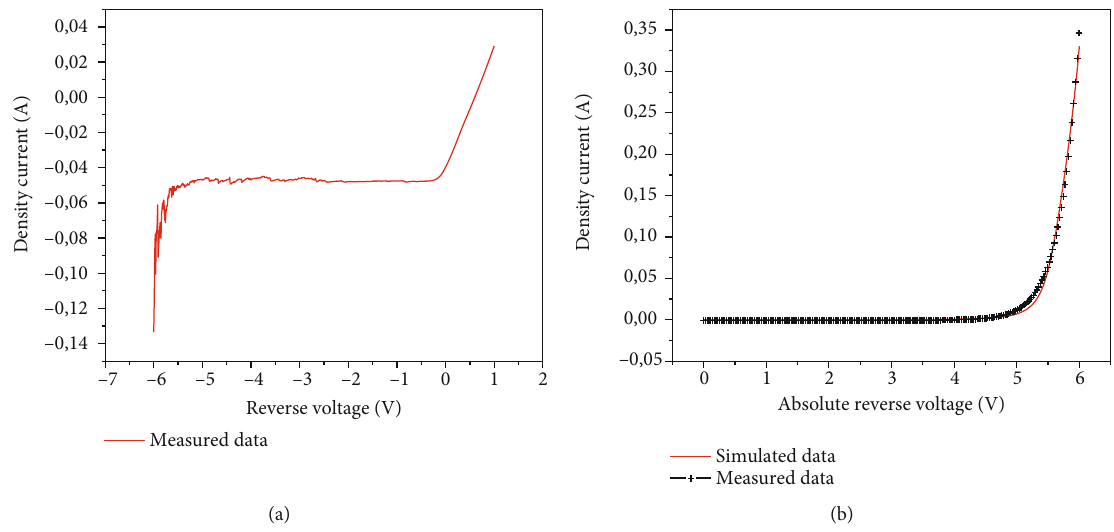
Figure 4: Comparison between the I - V characteristics of a PV cell in receiver mode: measured data versus simulated Table 1: Extracted parameters used in the simulation model. Parameters